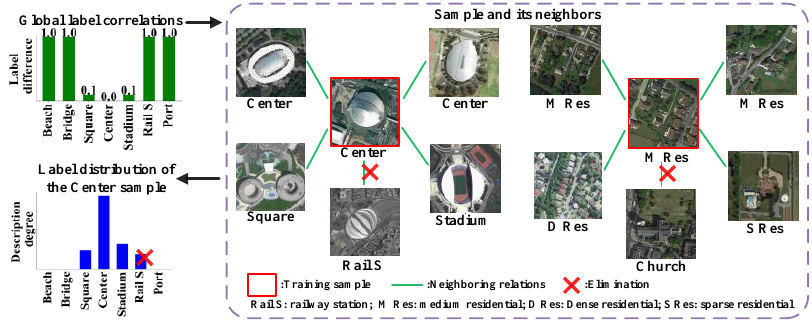
Figure 2. Fundamental idea of this paper.